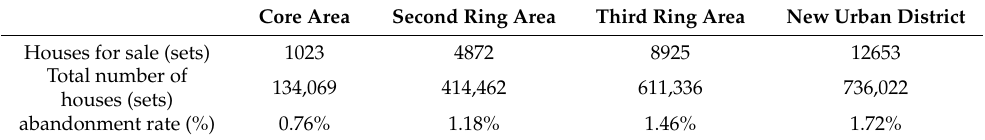
Table 1. Descriptive analysis of the abandonment rate in four circles in Kunming’s Main Urban District.